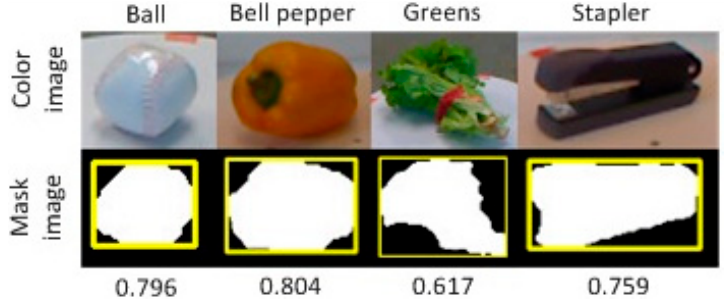
Figure 2. Compactness is measured by the ratio of the object area to the area of its smallest bounding box. The first row is the color image of each object. The second row is the mask image indicating the location of the object in the color image. The bounding box is highlighted in yellow.